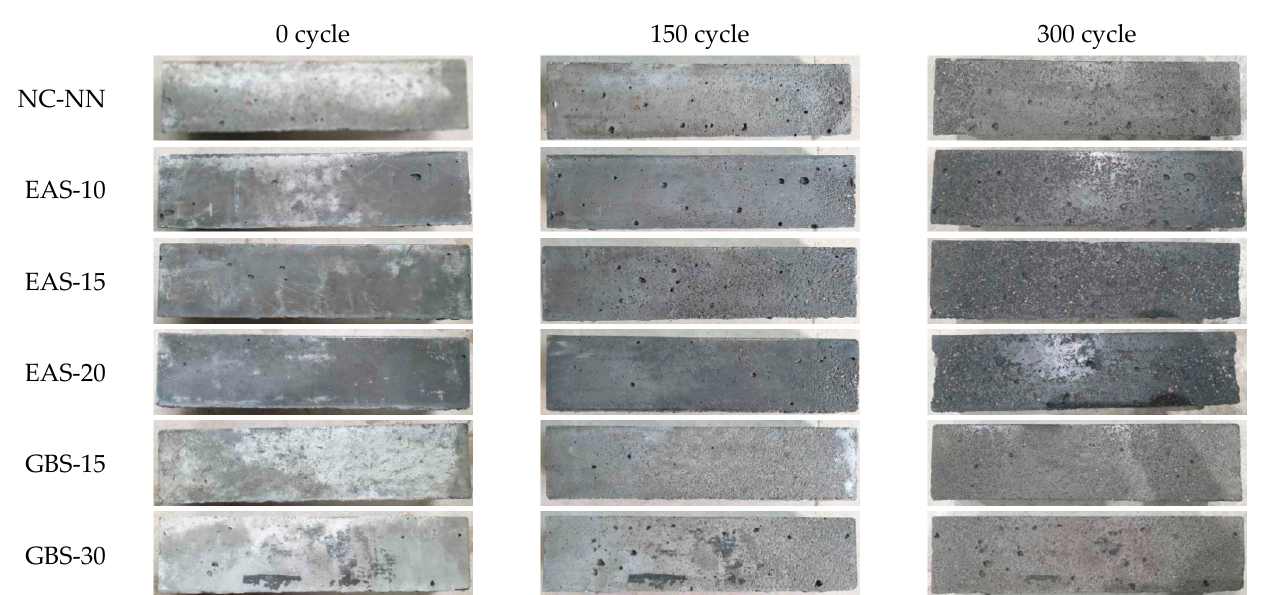
Figure 11. Concrete surface scaling after various amounts of freezing and thawing cycles. Table 3. Properties of HSC containing slag after freezing and thawing cycles.